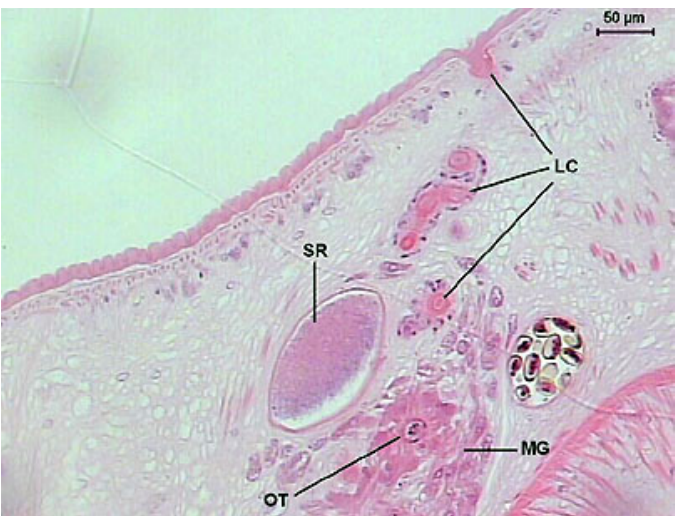
Figure 16. Transversal section of the ovary and Mehlis’ gland of the Sticholecitha serpentis acetabulum. MG – Mehlis gland, SR – seminal receptacle, LC – Laurer’s channel, OT – ootype. HE.